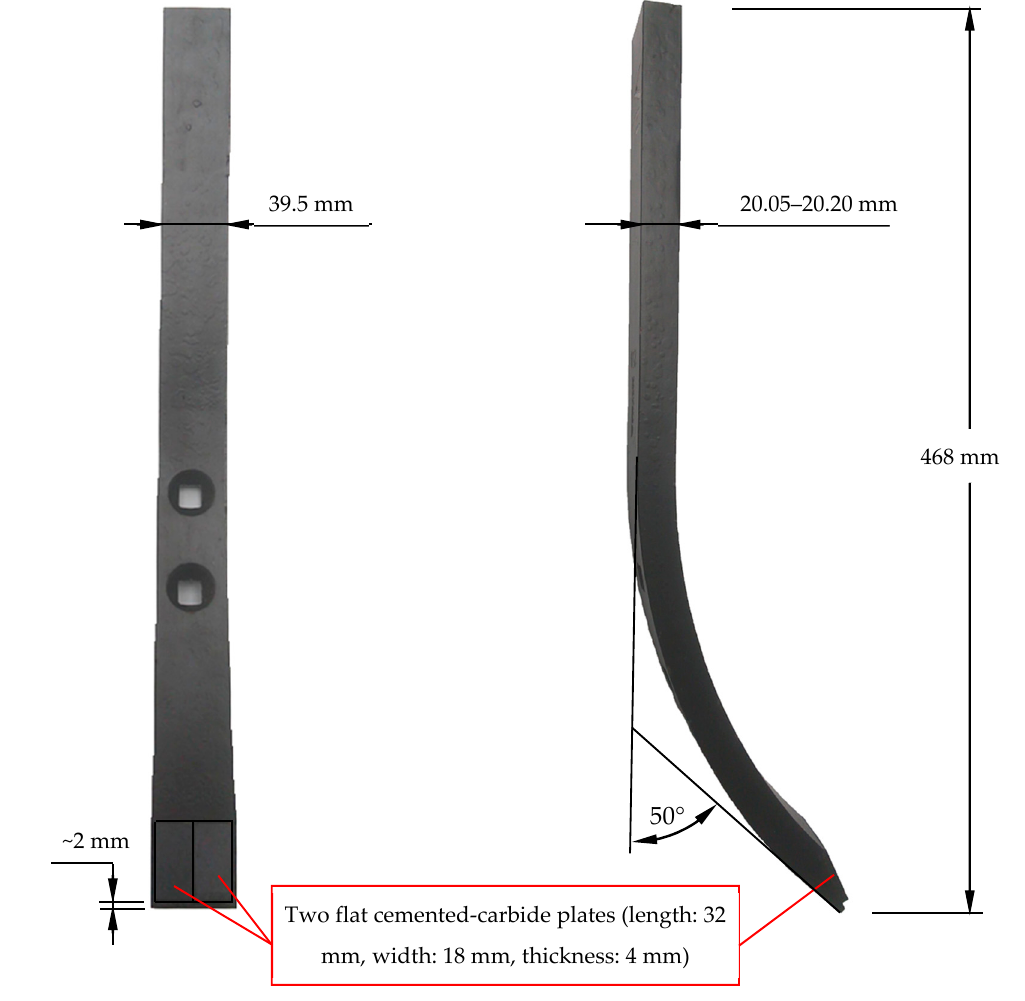
Figure 2. Tested chisels: variant B.